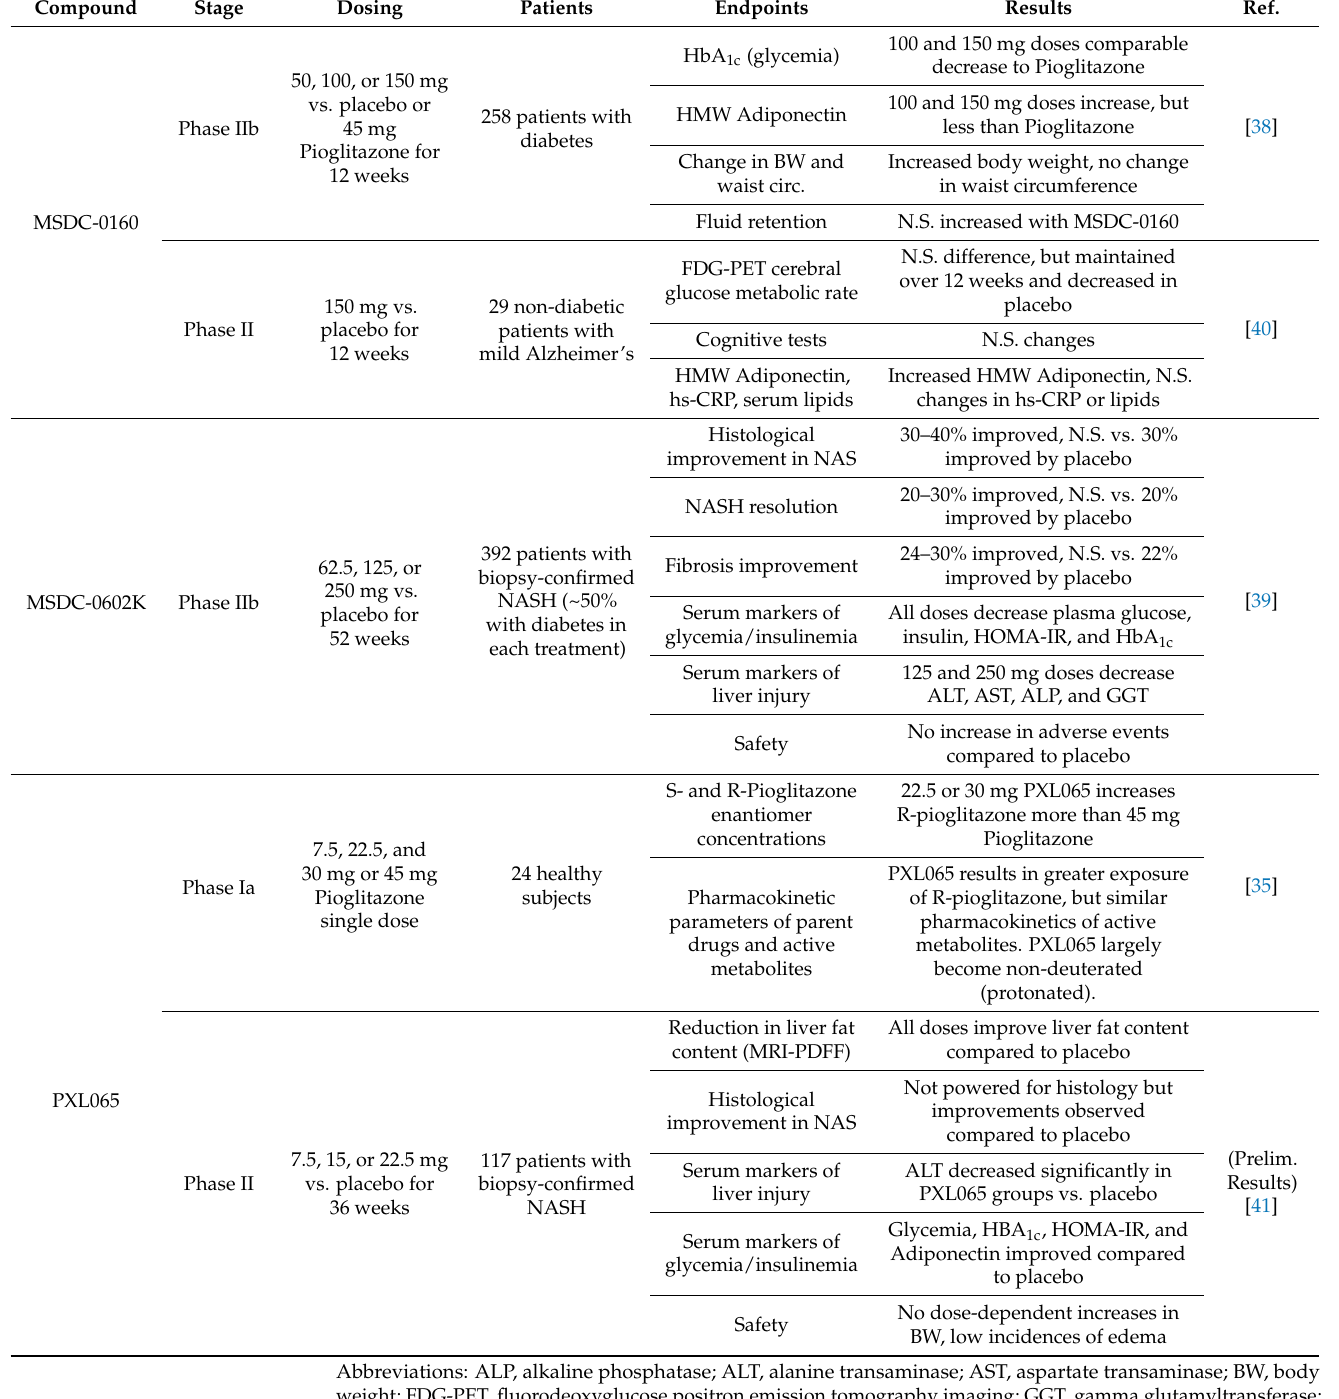
Table 1. Clinical trials for MPC-specific agents in clinical